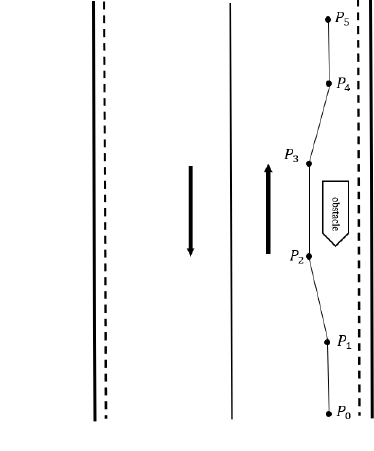
Figure 7. Diagram of small curves in cycling trajectory: ( a ) changing lanes; ( b ) avoiding obstacles.